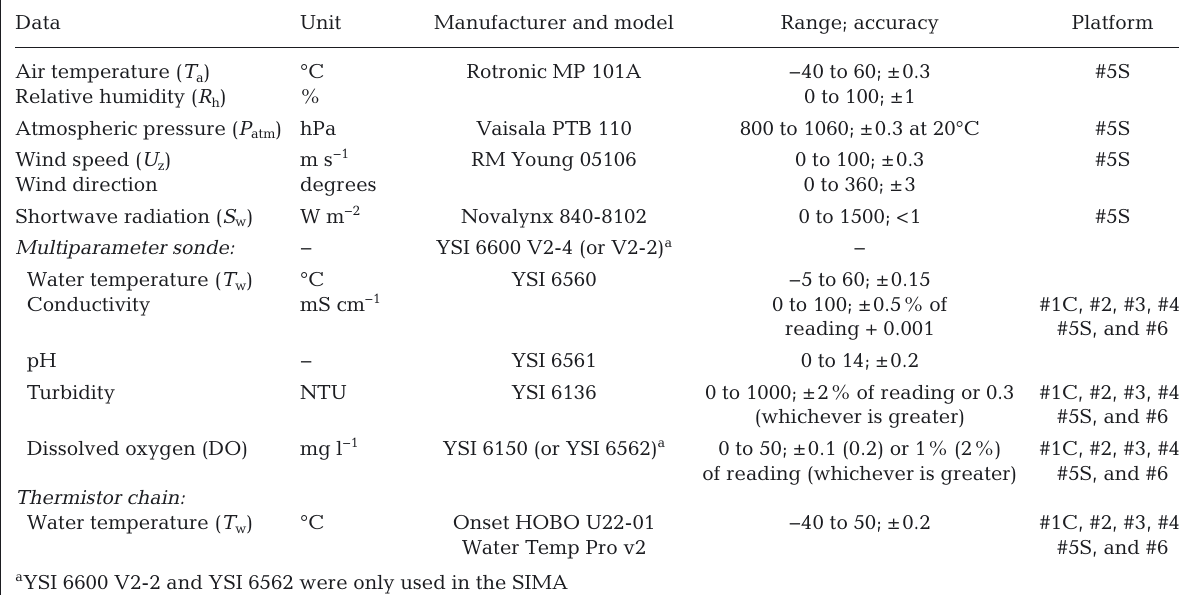
Table A1. Meteorological and water quality parameters collected by Integrated System for Environmental Monitoring (SIMA) and SIMA-Aquaculture at the 6 platforms (see Fig.